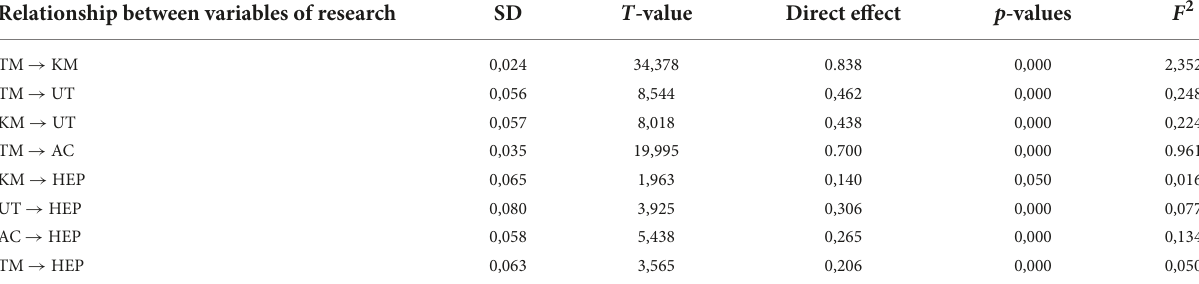
TABLE 6 Results of the structural equations model. Relationship between variables of